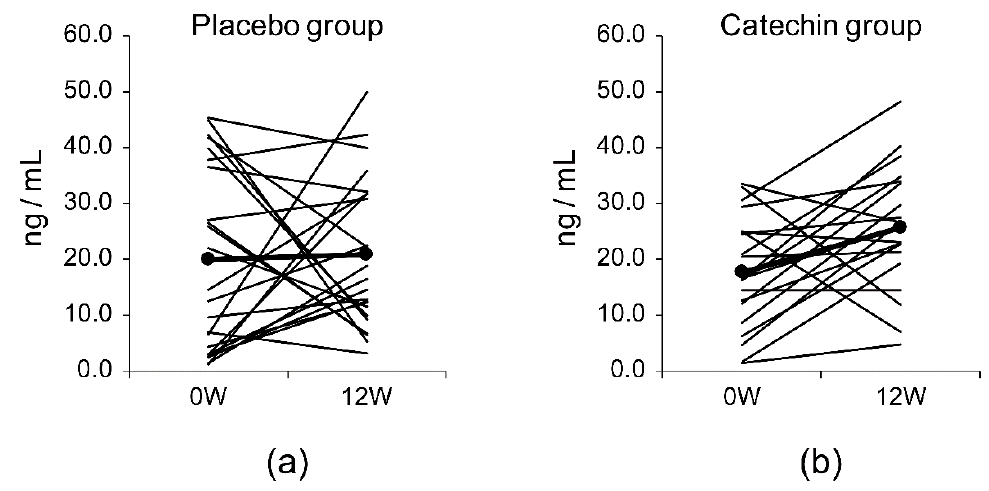
Figure 2. Serum BDNF levels over 12 weeks (W) in the ( a ) placebo group and ( b ) catechin group.